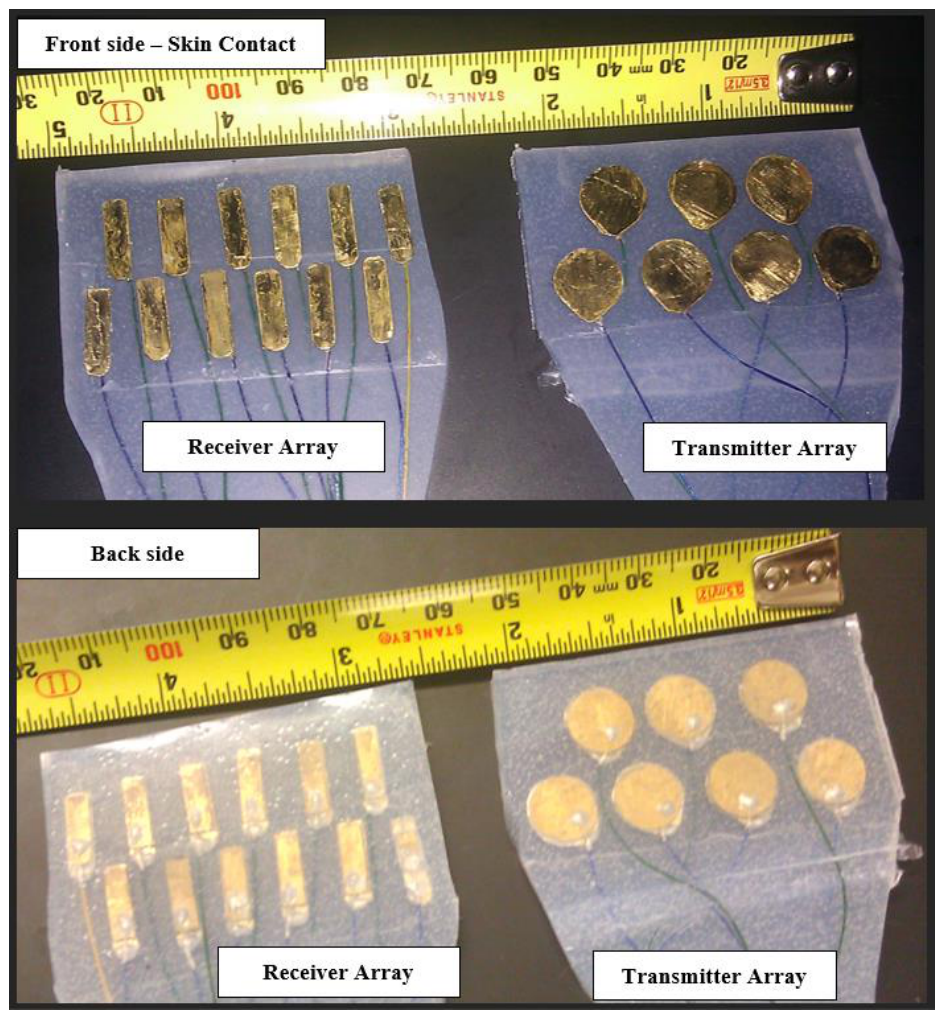
Figure 2. The transmitter and receiver arrays were fabricated for this study. Gold-plated PZT elements were soldered to the brass layer using silver epoxy. The cable electrodes were cold welded to the transducer plates using silver epoxy. The cable is a medical-grade 20-cable shielded ribbon coax cable, each coax having a 0.08 mm diameter [AWG 40] (Hitachi Cable Manchester, Manchester, New Hampshire, USA). The elements were placed within a flexible silicone rubber mold.